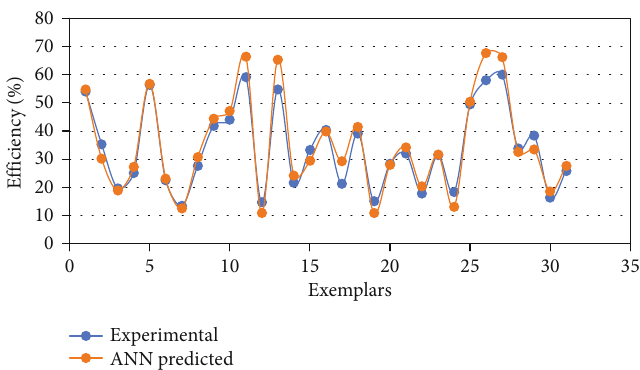
Figure 9: Evolution of the MSE in the training and validation phases for the best model obtained.